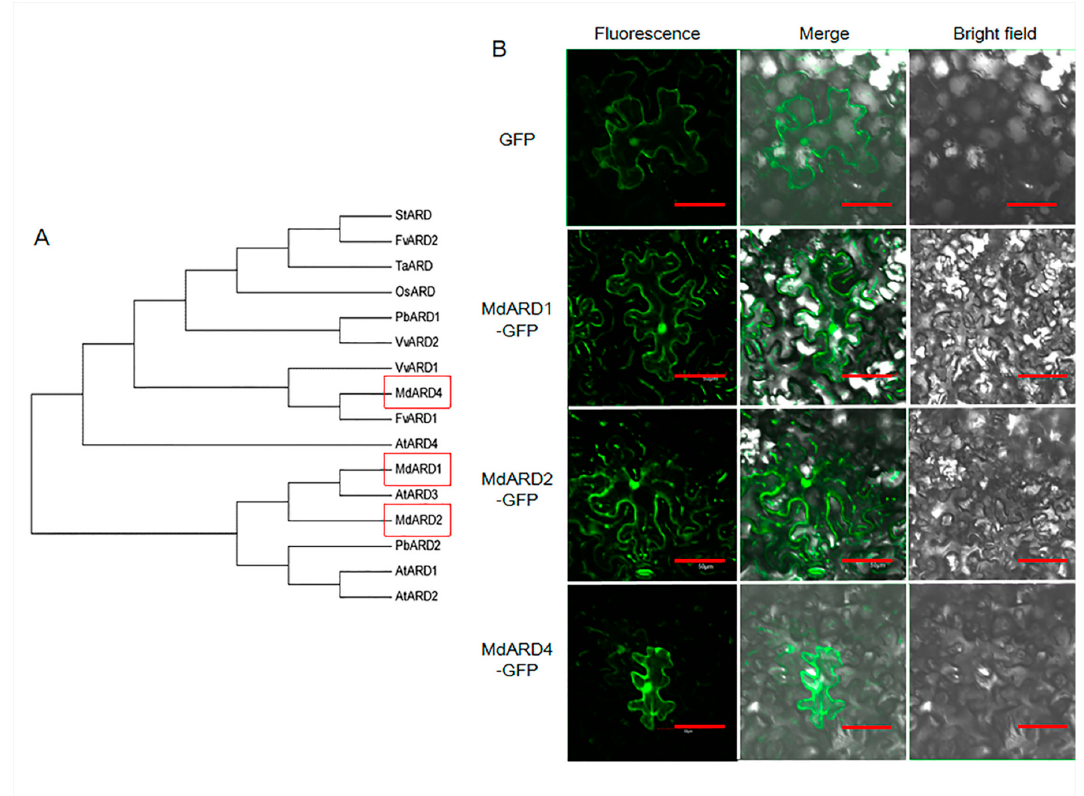
Figure 1. ( A ) Phylogenetic analysis among plant acireductone dioxygenase (ARD) proteins and ( B ) subcellular localization of GFP (green fluorescent protein) and MdARD-GFP. GFP or MdARD-GFP fusion protein were transiently expressed in Nicotiana benthamiana epidermal cells and visualized by confocal microscopy. The fluorescent green signal in the dark field or merged field shows the localization of GFP or MdARD-GFP fusion protein. Bars, 50 μ m. Md, Malus domestica ; MdARD1 (MH481533),